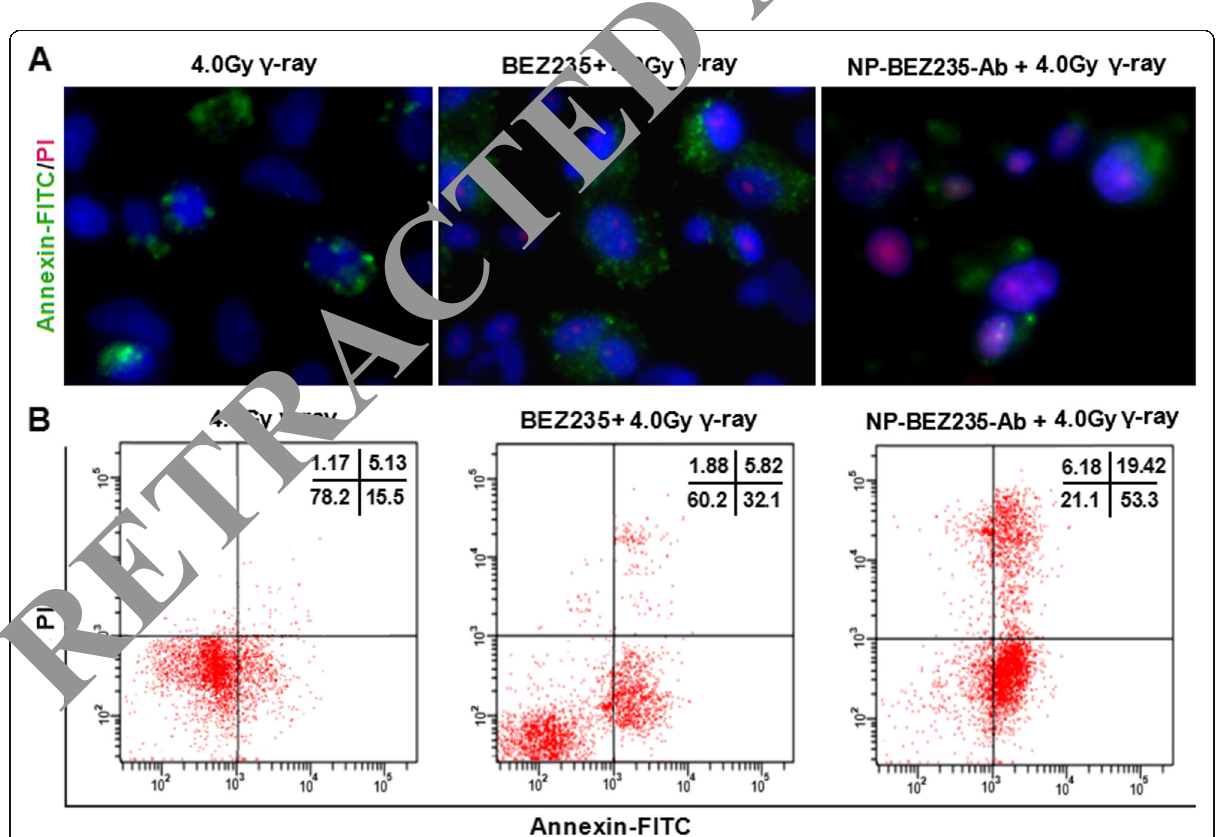
Fig. 7 Effect of NP-BEZ235-Ab on apoptosis of irradiated HepG2 cells. Early and late apoptosis was significantly increased in HepG2 cells treated for 72 h with 4 Gy γ -irradiation, and apoptosis was more in cells treated with NP-BEZ235-Ab (equivalent 10 nM free BEZ235) + 4 Gy γ -ray than in cells treated with BEZ235(10nM) + 4 Gy γ -ray or with 4Gy γ -ray only. This graph represents an average of the three experiments in